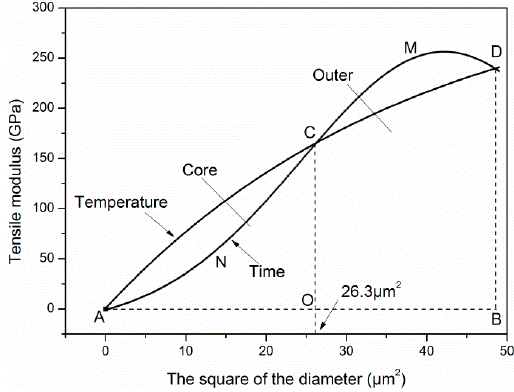
Figure 17. Time–temperature equivalence on the radial distribution of tensile modulus .